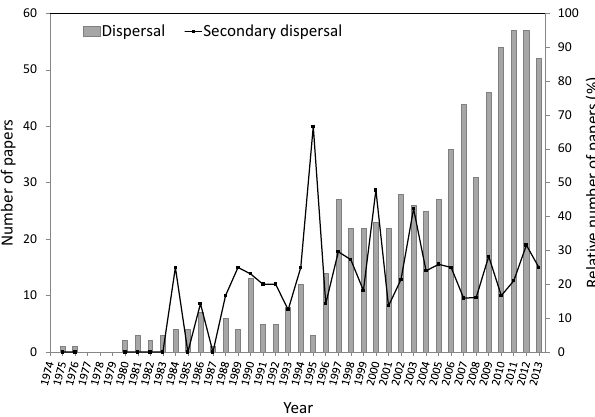
Figure 1. Temporal evolution of the total number of papers on seed fate and dispersal in drylands published between 1974 and 2013, along with the evolution of the relative number of papers focus- ing on secondary seed dispersal. Data were obtained from online keyword searches with Scopus database using the “All Document Type” option, date range from 1974 to 2013 and the following for- mulae in topics: (a) (“dispersal” or “seed fate” and “seed”) and (arid or semiarid or semi-arid or dryland or “patchy vegetation” or “patchy ecosystem” or patchiness or mosaic or desert) for seed fate studies in general; (b) (“dispersal” or “seed fate” and “seed”) and (arid or semiarid or semi-arid or dryland or “patchy vegetation” or “patchy ecosystem” or patchiness or mosaic or desert) and (“sec- ondary dispersal” or “secondary seed dispersal” or “seed removal” or “seed movement” or “secondary seed movement” or “secondary movement” or “secondary process” or “post dispersal” or “post- dispersal” or “seed bank” or “seedbank”) for secondary seed dis- persal